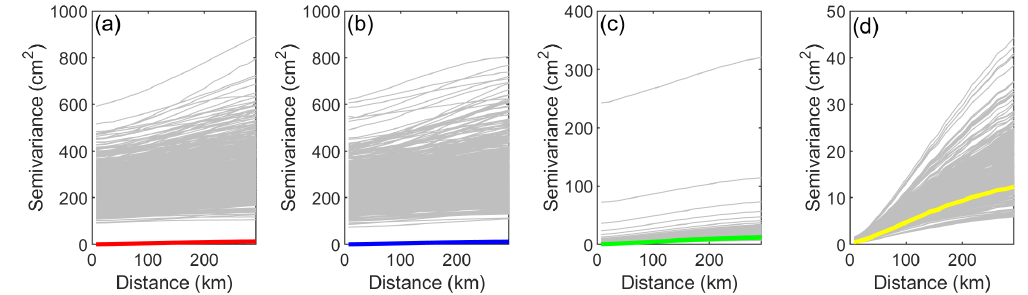
Figure 5. Variograms of the particles for the different reordering strategies for 28 February 2012: (a) ensemble open loop; (b) no reordering, (c) sorting and (d) Schaake shuffle. Solid lines represent the variograms of the estimated SWE as displayed in Fig. 3, and grey lines represent the variograms of individual